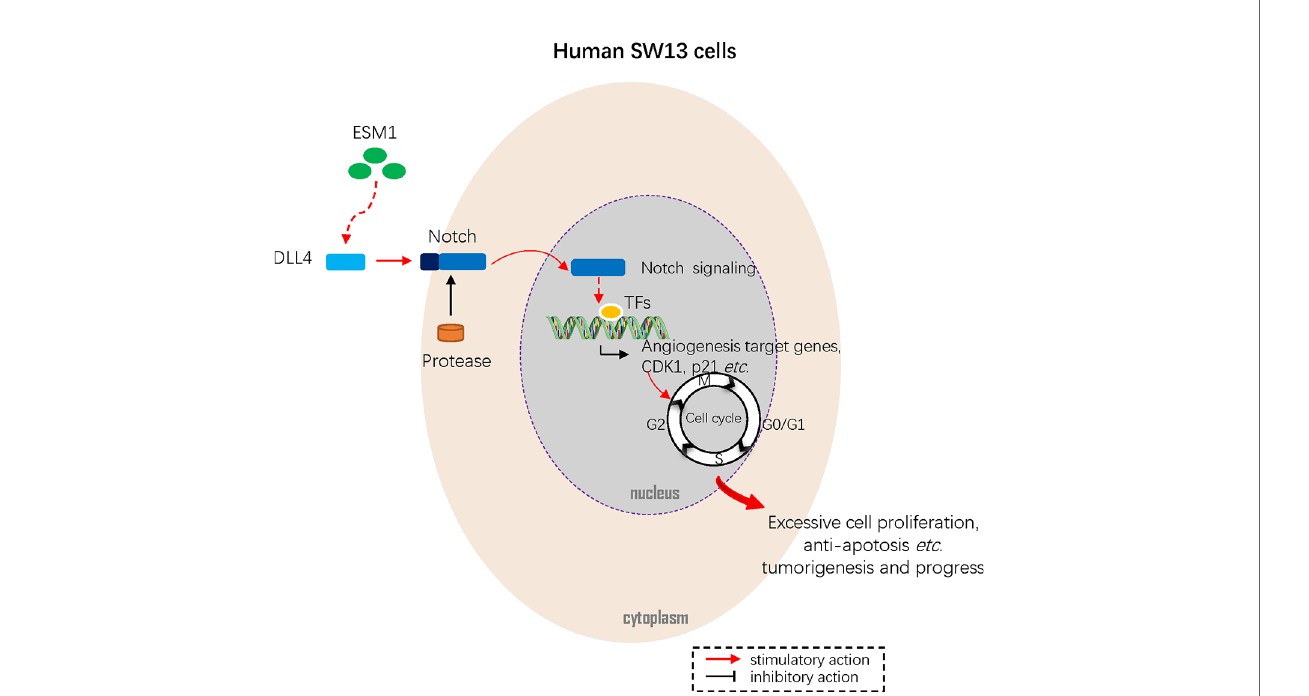
FIGURE 9 | Mechanism diagram. Overexpressed ESM1 upregulated CDK1 and p21 mediated G2/M-phase transition, cell proliferation, cell migration, cell invasion, and accumulation of tumor mutation burden (TMB) via DLL4-Notch signaling